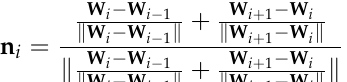
Figure 28. Situation of UAV switching from one waypoint to the next waypoint. At this time, the aircraft flies from point w i − 1 to point w i , and vector n i can be represented by Equation (23).